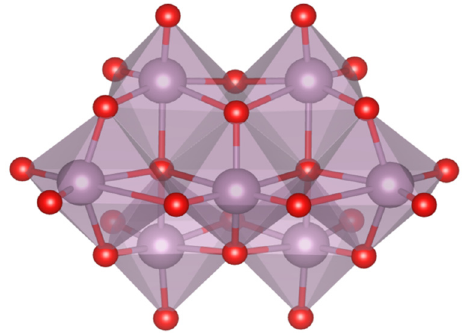
Figure 32. Polyhedral representation of the {Mo 7 } POM used in our work.